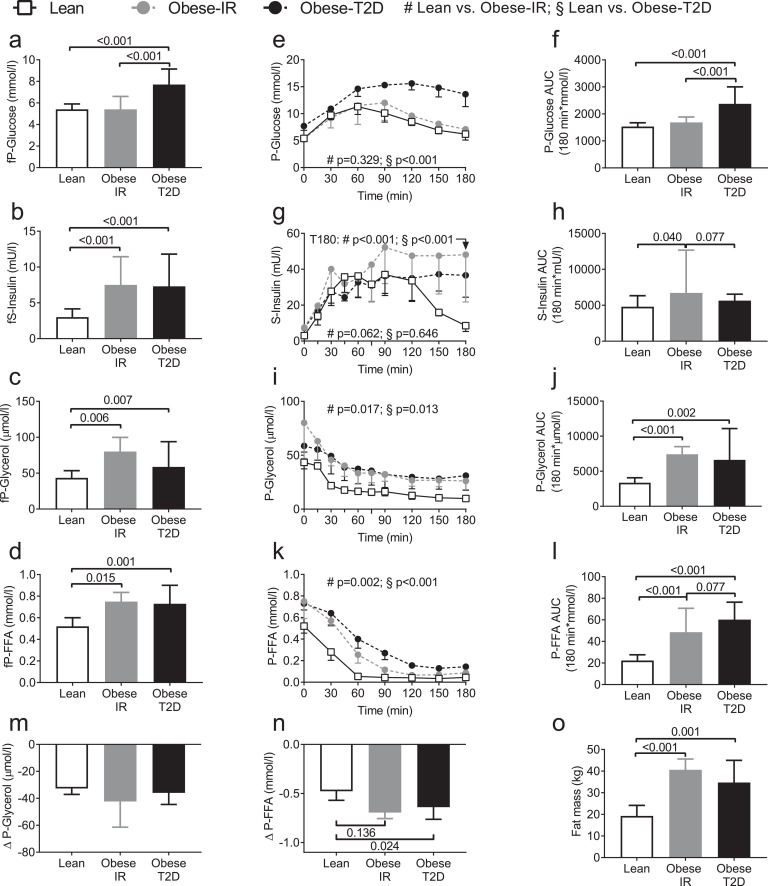
Circulating concentrations of insulin and metabolites in Lean, Obese-IR, and Obese-T2D subjects.Overnight fasting levels of: (a) plasma glucose (fP-Glucose); (b) serum insulin (fS-Insulin); (c) plasma glycerol (fP-Glycerol); and (d) plasma free fatty acids (fP-FFA). During an oral glucose tolerance test (OGTT) we measured the levels of: (e) plasma glucose (P-Glucose), and (f) the area under the curves (AUC) in e; (g) serum insulin (S-Insulin) and (h) AUC of g; (i) plasma glycerol (P-Glycerol), and (j) AUC of i; (k) plasma free fatty acids (P-FFA), and (l) AUC of k. Maximum decrease from the baseline value during the OGTT of the levels of (m) P-Glycerol, and (n) P-FFA. (o) Fat mass of study participants. Data are presented as median and error bars indicate interquartile range (IQR) for each group. n=9 in each group for all panels [Mann-Whitney U-test for bars and time 180 in figure (g), mixed-effects models for curves].